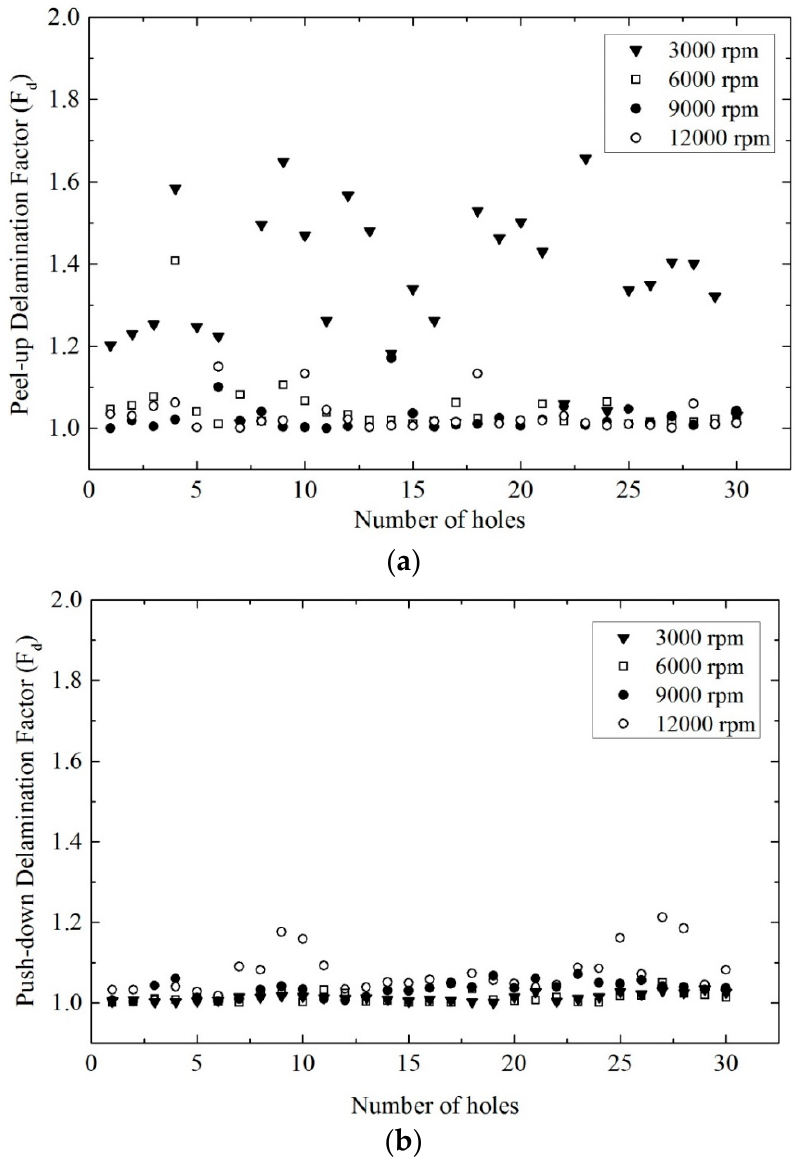
Figure 7. Drilling induced delamination with varying cutting speed at feed rate of 400 mm/min: ( a ) peel-up delamination factor; ( b ) push-down delamination factor.